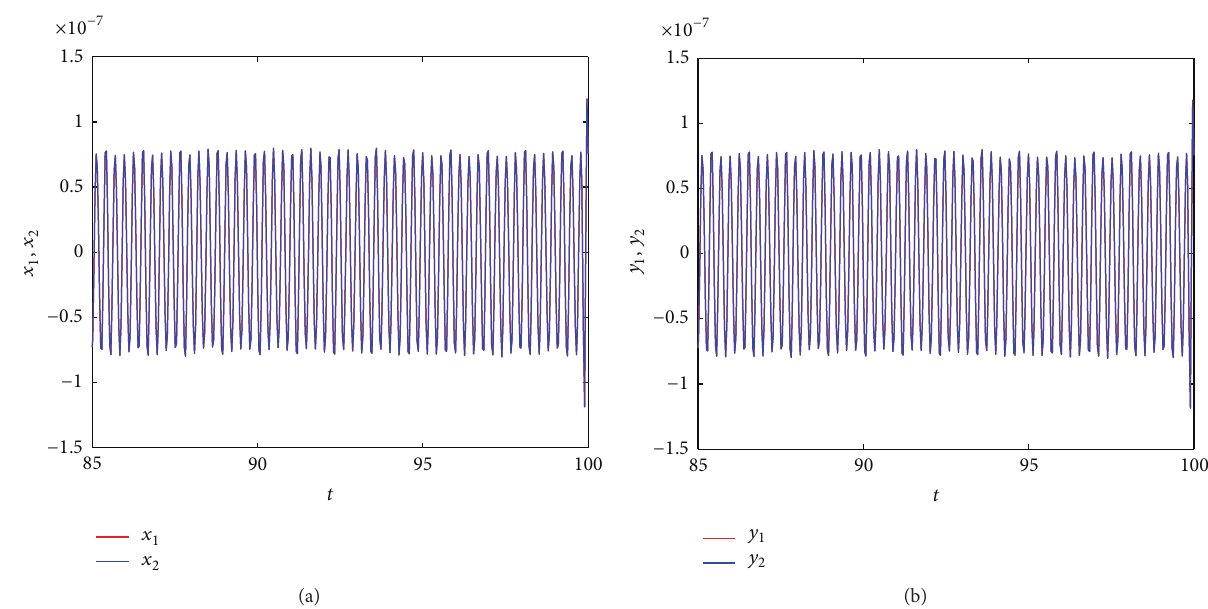
Figure1:When 𝜏 ∈ [0,𝜏 − 0 ] ,thezeroequilibriumisunstable. 𝑇 = 1/70 andinitialconditions: 0.000000001⋅(1, 1, 1,1, −1, −1,−1, −1) , 𝜏 = 0.001 .